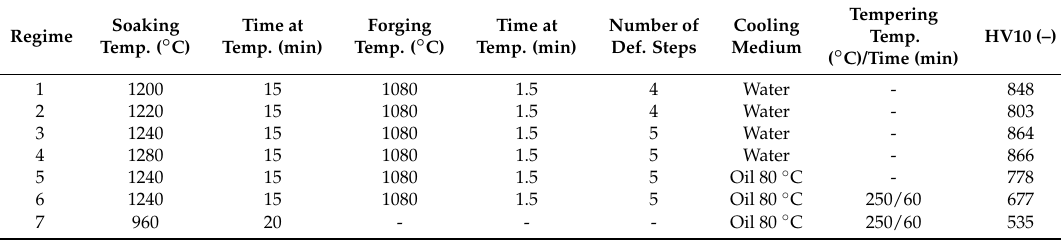
Table 3. Parameters of heat treatment and hardness values.